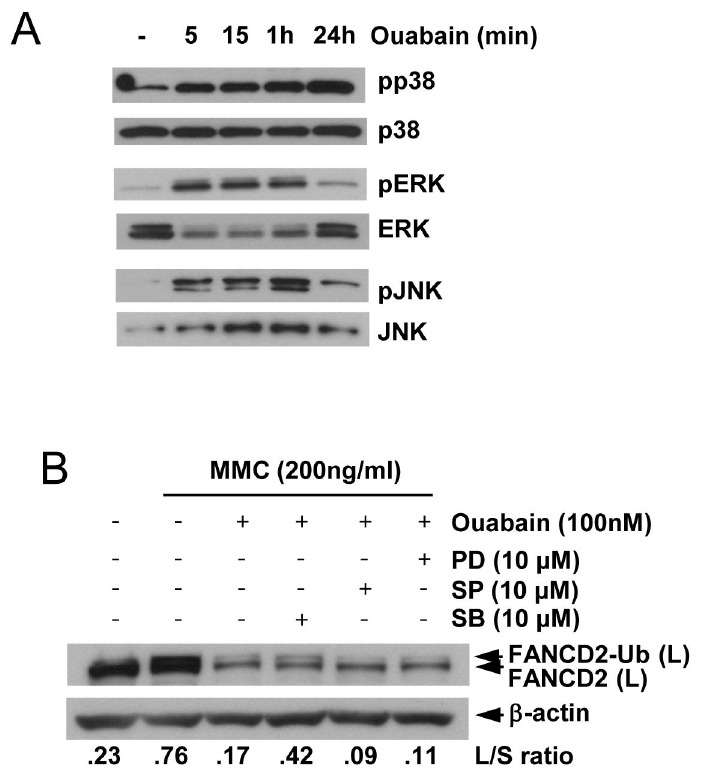
Figure 4. Ouabain inhibits the FA/BRCA pathway through p38 kinase. (A) Protein extracts from U2OS cells treated with 100 nM ouabain for the indicated times were analyzed by Western blotting using antibodies against phosphorylated p38, p38, phosphorylated ERK, ERK, phosphorylated JNK, and JNK. (B) U2OS cells were pretreated with the indicated concentration of MAPK inhibitors for 30 min and then with 100 nM ouabain for 30 min and incubated in 200 ng/ml MMC for 24 h. The cell lysates were subjected to Western blot analysis using antibodies to FANCD2 and β-actin. PD, PD 98059 (ERK inhibitor); SP, SP 600215 (JNK inhibitor); SB, SB 203580 (p38 inhibitor).